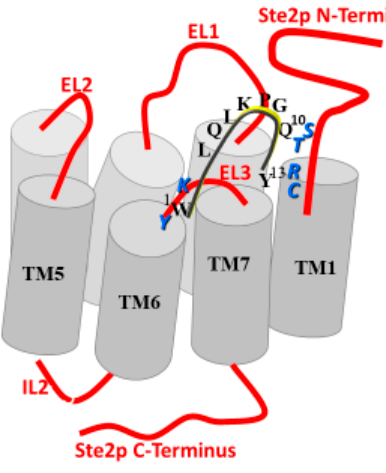
Figure 9. Binding of α -factor to Ste2p. Glutamine (Q 10 ) of the C-terminus of α -factor binds to residues Ser47 and Thr48 at the interface of the receptor’s N-terminus and the extracellular face of TM1 and tyrosine (Y 13 ) binds to Arg58 and / or Cys59 in TM1. The bending of the pheromone around the loop region facilitates the interaction between the tryptophan (W 1 ) at the N-terminus of α -factor and residues Y266 and K269 in TM6 and EL3. The N-terminus is shown interacting with EL1. α -Factor residues are indicated in black (not all the residues of the pheromone are shown in the figure), Ste2p residues are shown in blue, Ste2p loops and termini are in red, and transmembrane domains are in gray.